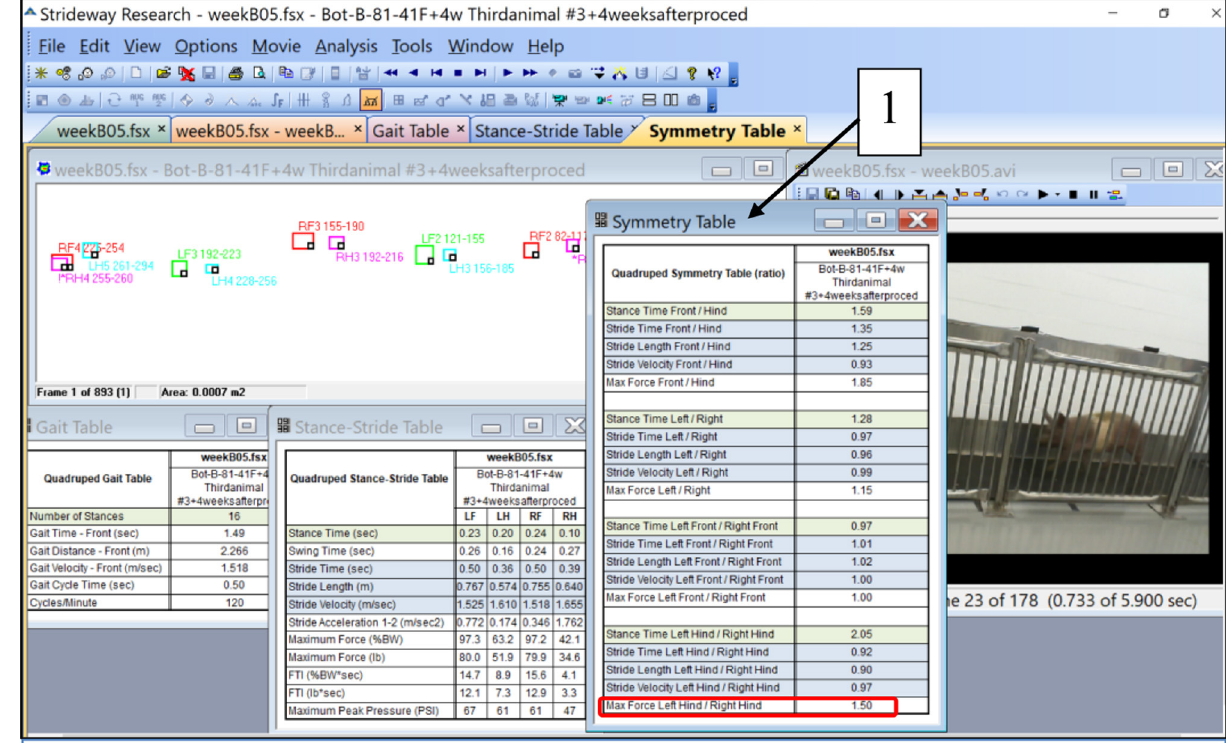
FIGURE 1 | Illustration of the parameters of quadruped gait calculated by the Strideway software including a Symmetry Table (1). A ratio “Max Force Left Hind/Right Hind” at the bottom of the Symmetry Table (encircled with red) was taken as a parameter called “Asymmetry Index (AI)” (see Table 2 and the graph in Figure 3 ).